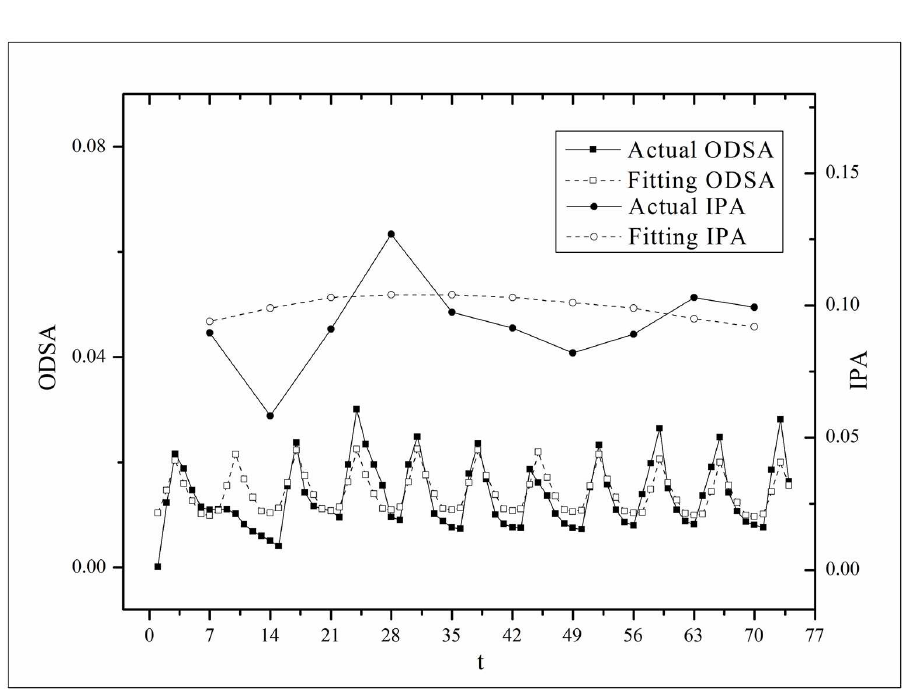
Fig 7. Two-step fitting results for the Kaputori